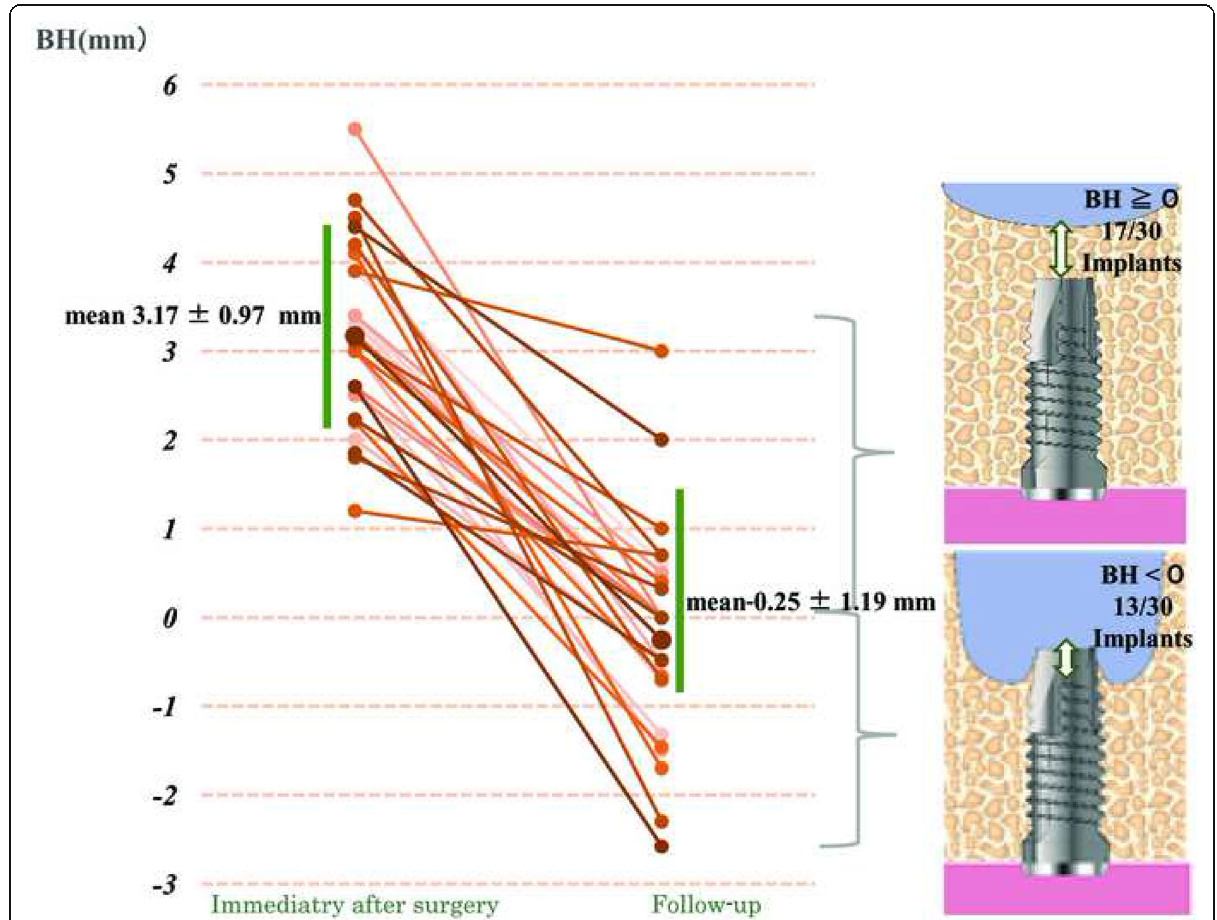
Fig. 5 Changes in BH in 30 implants. The mean BH immediately after surgery was 3.16 ± 0.97 (1.2 – 5.5) mm, while the mean BH at follow-up was 0.25 ± 1.19 ( − 2.58 – 3.00) mm; a mean decrease of 3.42 ± 1.43 (0.50 – 6.80) mm. After surgery, the maxillary sinus floor was below the implant apex (BH < 0) in 13 of 30 implants. BH, augmented bone above apex of the